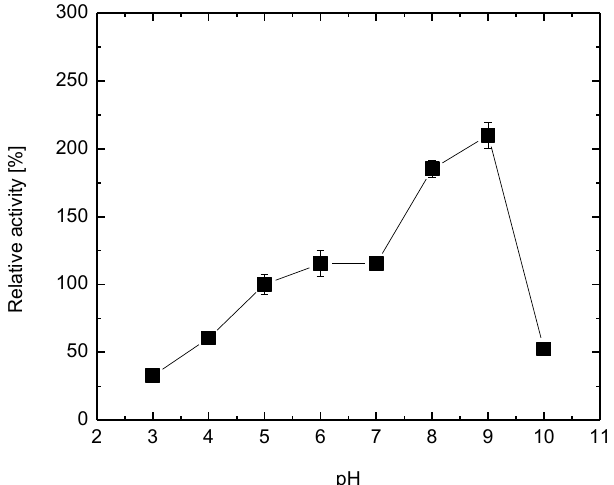
Figure 9. Effect of different pH on partial purified dextranse activity.